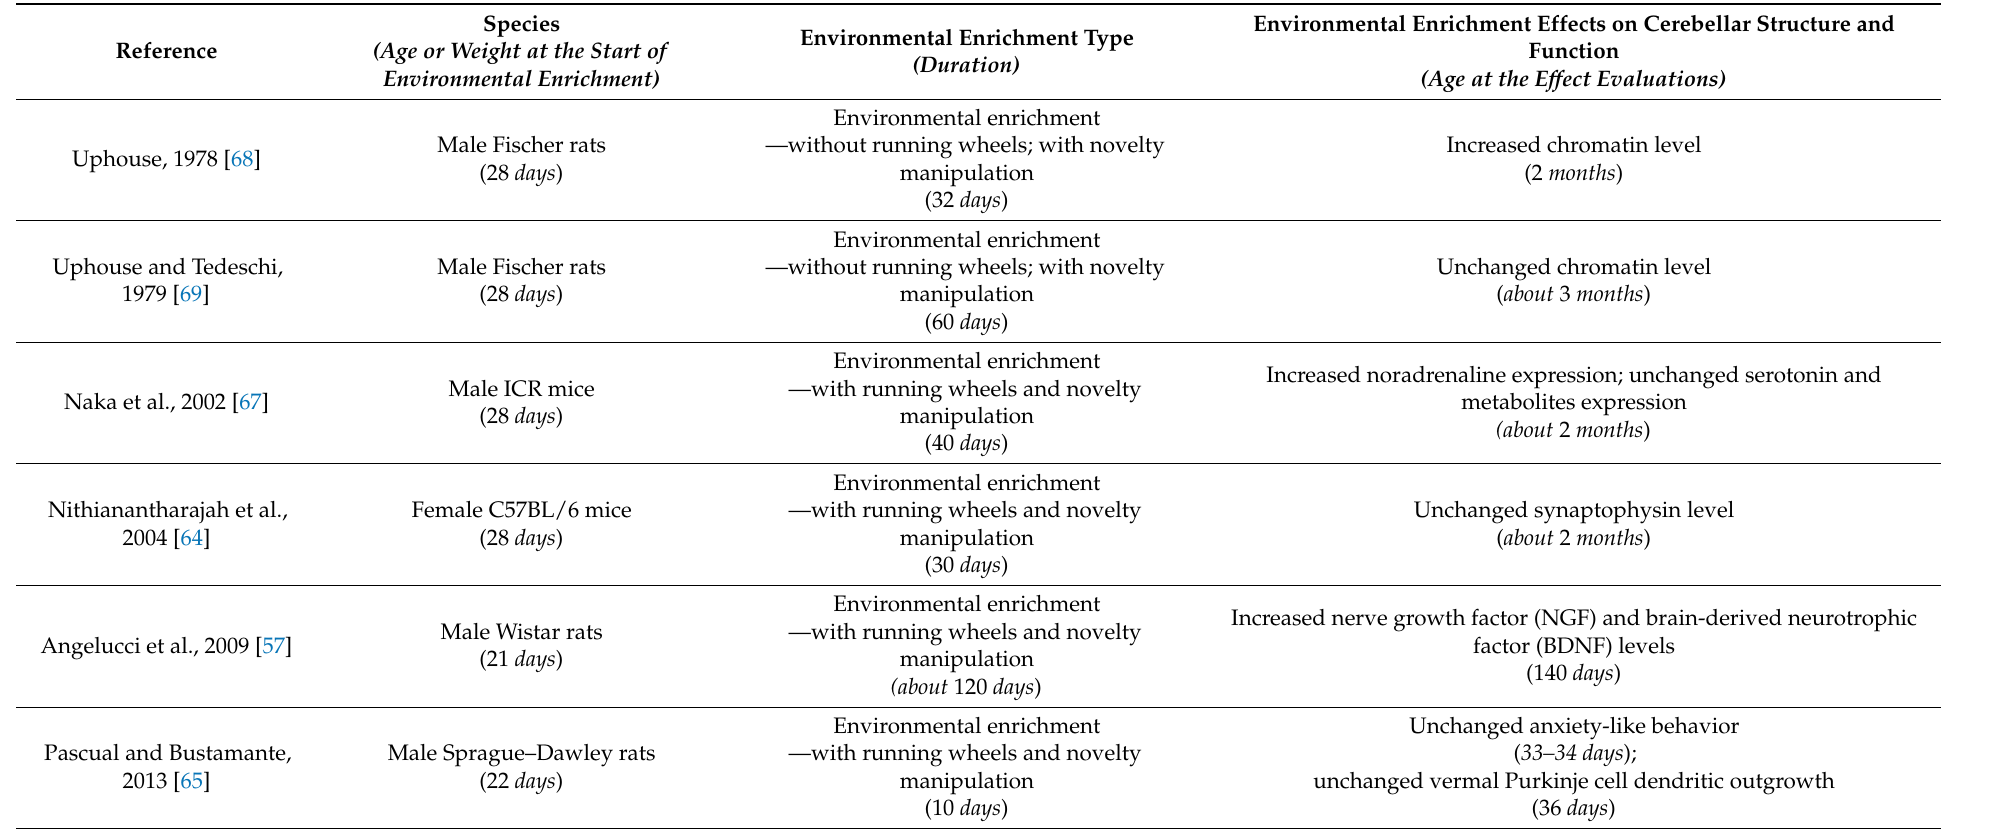
Table 1. Studies on environmental enrichment’s effects in healthy